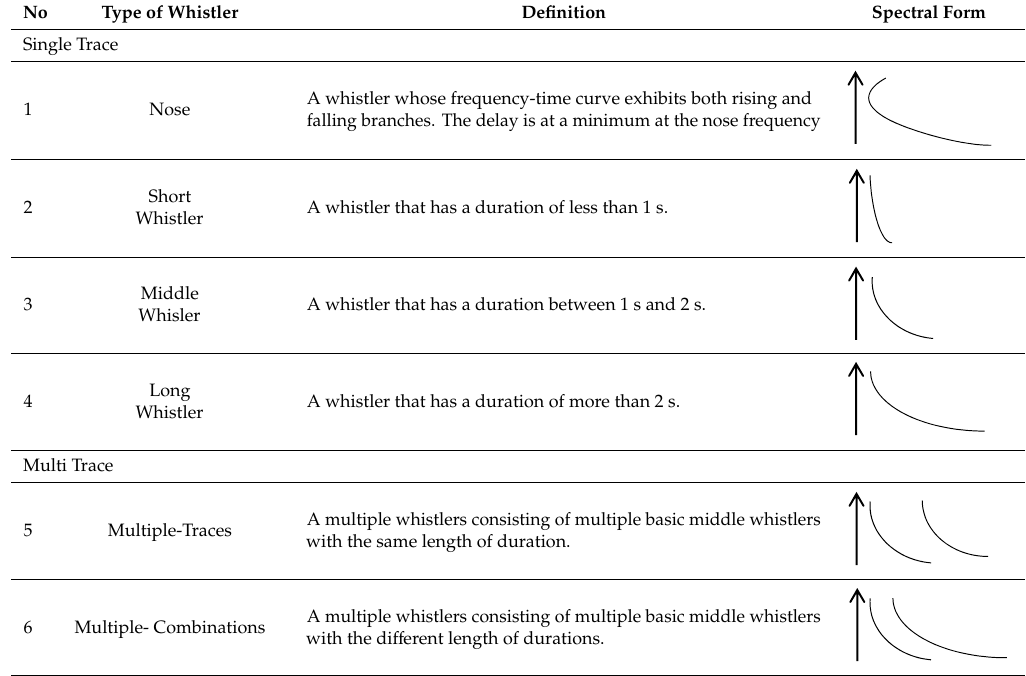
Table 1. Arase whistler map: Type and principal definitions of lightning whistlers partially 188 adapted from the original whistler atlas by Helliwell [17].